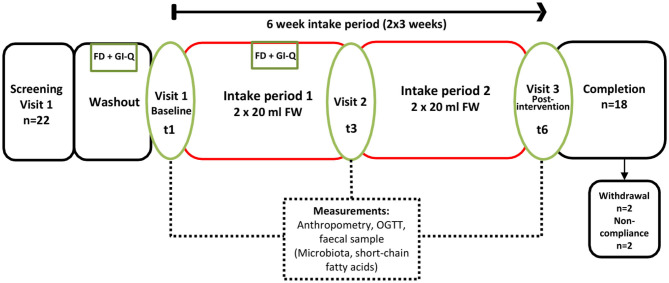
Study Flow (6 weeks continuous intake), single arm intervention, with three separate study visits at the Human Nutrition Unit (referred to as t1, t3, and t6). FD, 3-days food diary; GI-Q, gastrointestinal questionnaire; OGTT, oral glucose tolerance test.